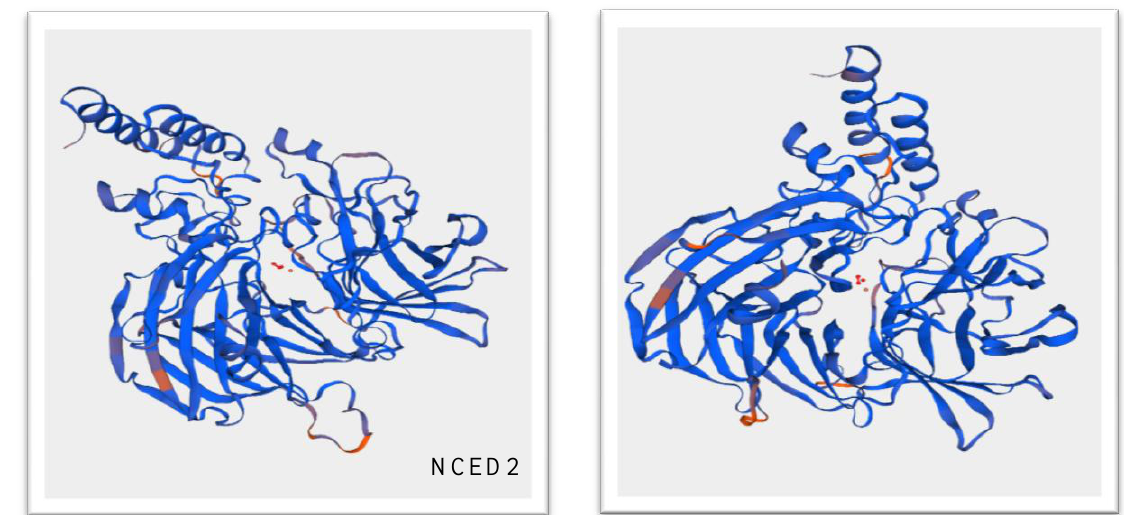
Figure 3. Predicted 3D structures of NCED